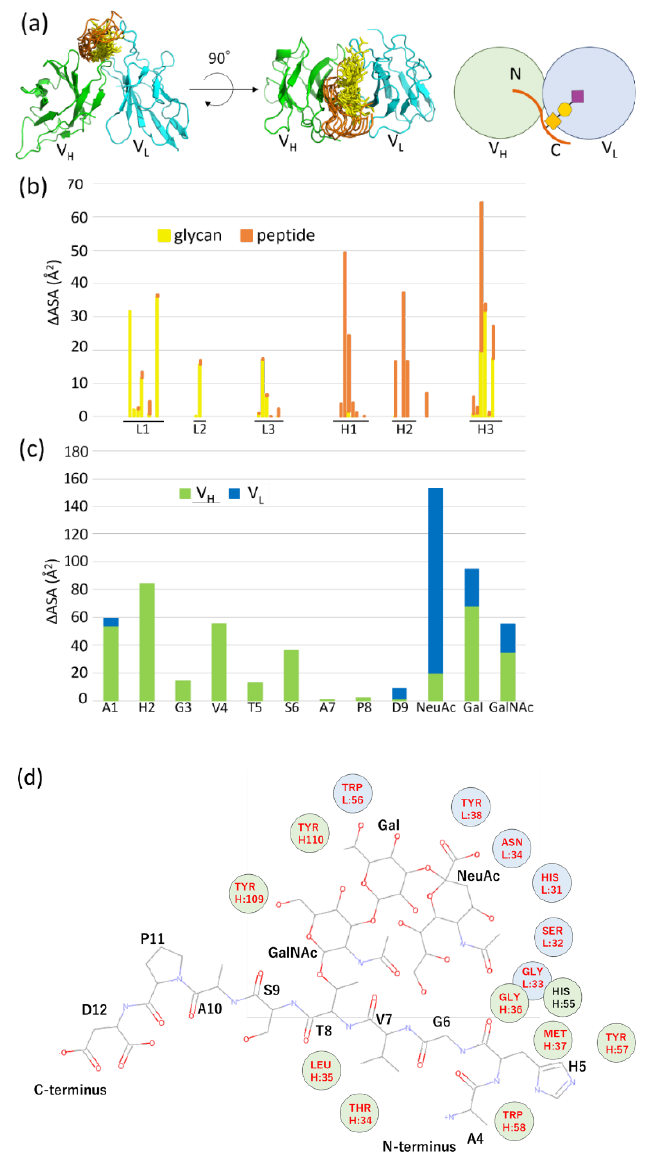
Figure 7. Docking simulations and analysis of MUC1-MY.1E12 binding site. ( a ) Ten selected docked poses that share a similar binding mode. V H is shown in green, V L in light blue, MUC1 O -glycan in yellow, and the peptide region in orange. Schematic drawing of the docking pose is shown on the right. ( b ) MUC1-binding region (epitope) of MY.1E12 based on difference in solvent accessibility ( Δ ASA) in the presence and absence of MUC1 ligand. Contributions of MUC1 glycan and the peptide portion to antibody binding are shown separately in yellow and orange, respectively. ( c ) Antibody-binding region (paratope) of MUC1 based on difference in solvent accessibility ( Δ ASA) in the presence and absence of antibody. Contributions of V H and V L to MUC1 binding are shown separately in green and blue, respectively. ( d ) Schematic 2D plot showing the interaction between MUC1 glycopeptide and antibody MY1E12. V H is shown in green, V L in light blue, CDR in red. The electrostatic potential of MY.1E12 Fv was calculated for one of the docking poses. The MUC1 glycan contains a negatively charged terminal NeuAc residue which may interact with a positively charged residue(s) on the CDR of MY.1E12. Indeed, the L1 loop